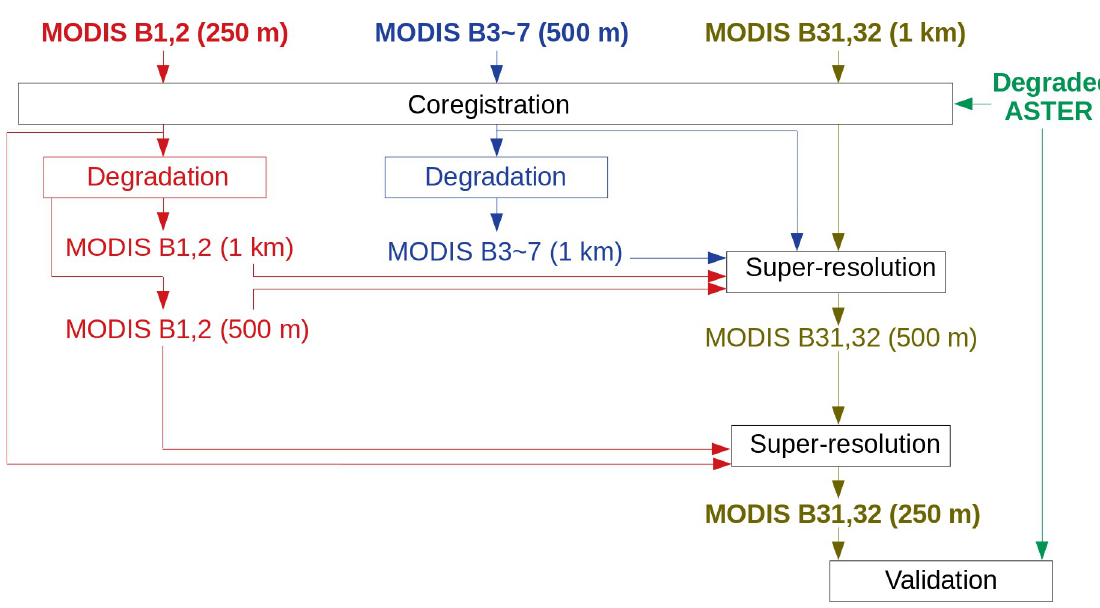
Fig 3. Proposed super-resolution